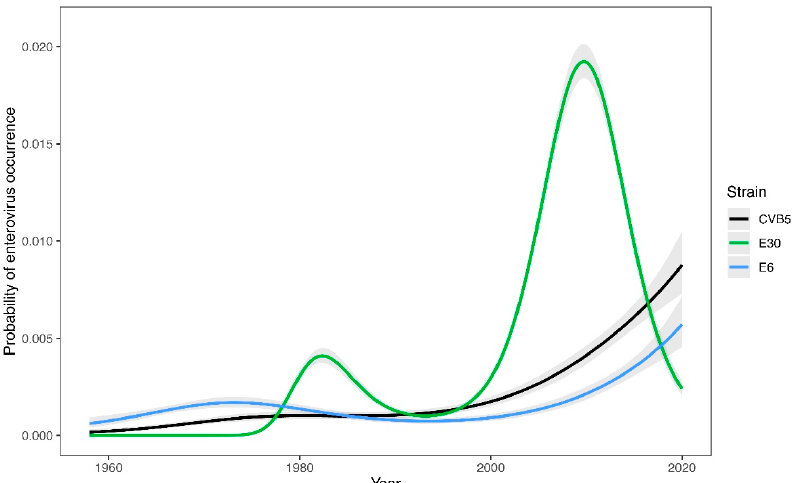
Figure 2. Temporal trends in probability of the three major enterovirus strains’ (coxsackieviruses (CV) and echoviruses (E)) occurrences in the Slovak Republic from 1958 to 2020. GAM-based estimates (lines) are displayed along with 95% confidence intervals.